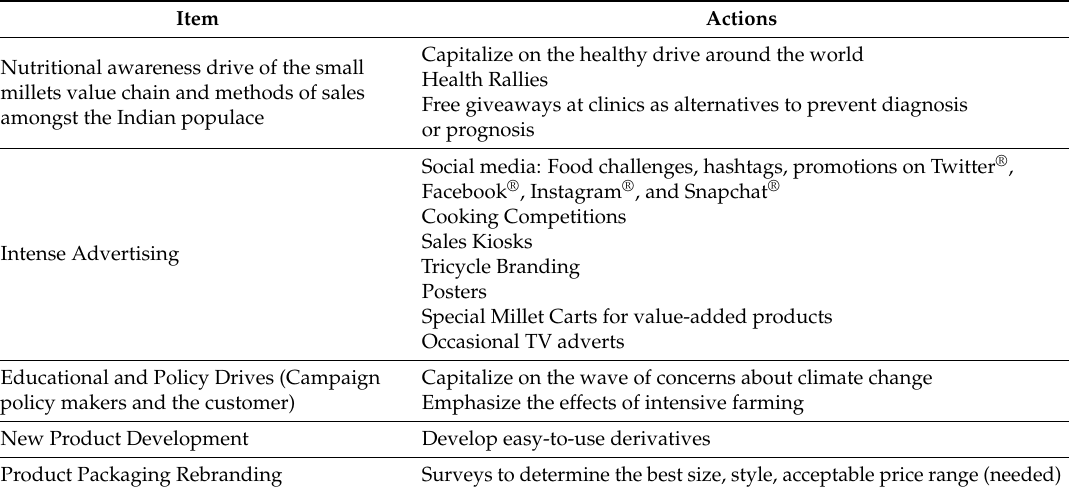
Table 2. Sample marketing plan to drive the small millets industry using the model